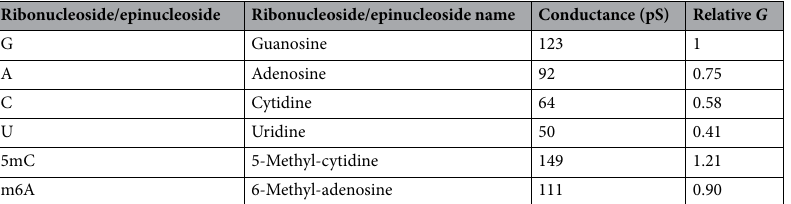
Table 1. Single-molecule conductance ( G ) and relative single-molecule conductance of ribonucleosides and epinucleosides (5mC and m6A). The ratio of the number of methylated A bases to the total number of A bases in the detected fragmented miR-200c-5p signals is defined as the methylation ratio (%) for m6A/A in the second column of this table. Similarly, the ratio of the number of methylated cytidine bases to the total number of cytidine bases is defined as the methylation ratio (%) for 5mC/C. Each of the base numbers is counted from the base composition of the fragmented